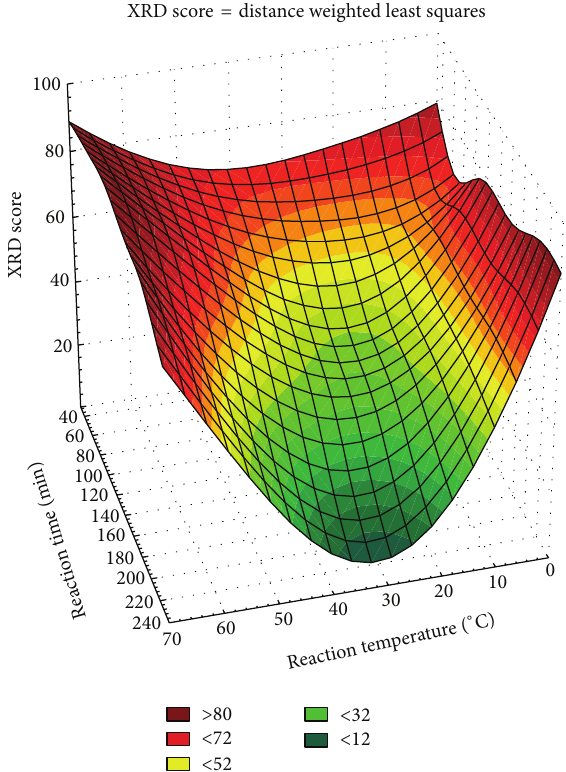
Figure 2: Modeling graph of mcallisterite crystal scores, which is drawn using Statsoft